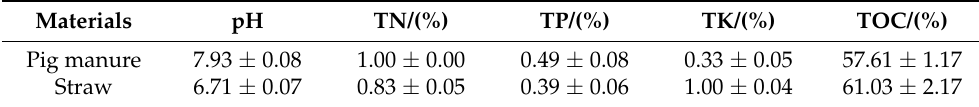
Table 1. Characteristics of compost